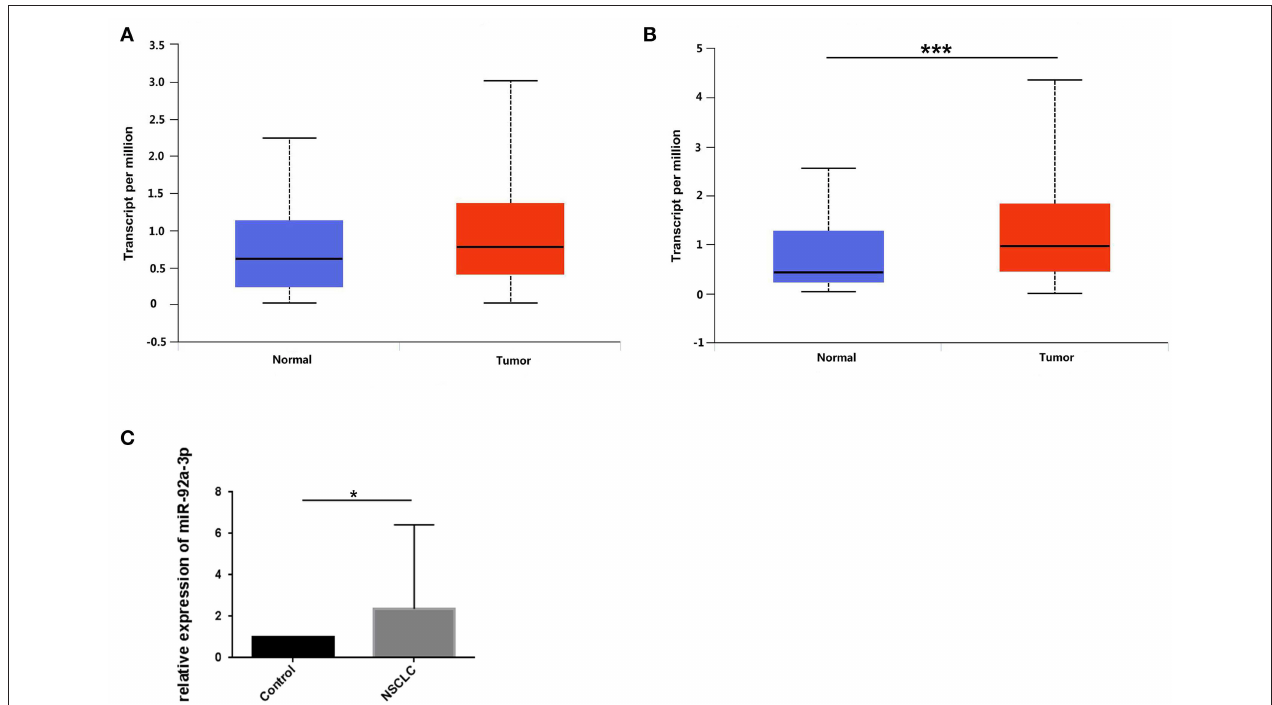
FIGURE 4 | miR-92a is upregulated in NSCLC. (A,B) Expression of miR-92a in lung adenocarcinoma (A) and lung squamous cell carcinoma (B) , values are expressed as Transcript per million, *** p < .001, t -test; (C) Expression of miR-92a in non-small-cell lung cancer tissues, normalized to the mean of control group and expressed as 2– 11 Ct, * p < 0.05, t